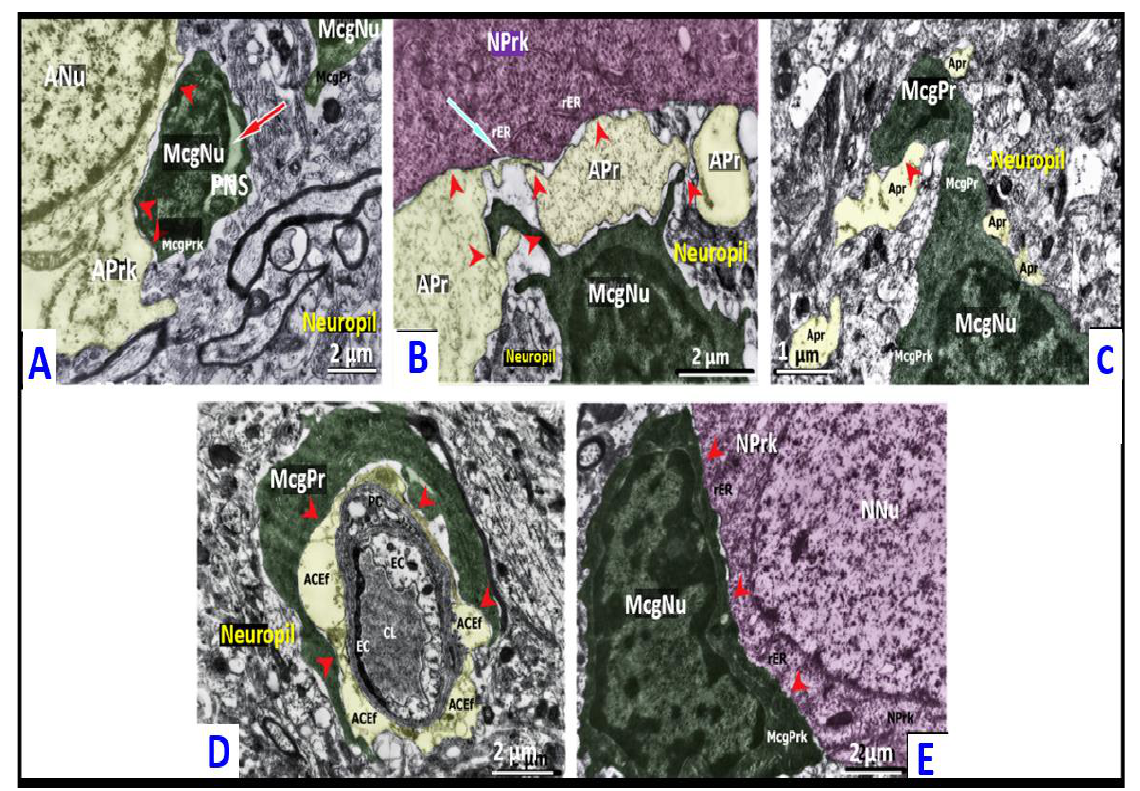
Figure 6. Microglial reactivity and interactions in acute hepatic encephalopathy. Panel ( A ) depicts an amoeboid microgliocyte (pseudo-colored green) forming direct dotted contacts (red arrowheads) with astrocyte (pseudo-colored yellow) with slight edematous changes. Note the enlarged perinuclear space of the microgliocyte (red arrow). Free extracellular space pockets surrounding microgliocyte plasma membrane. This image was taken at the border zone between the cortex and white matter of a non-survived rat (AILF-B group) 24 h after procedure. Panel ( B ) depicts an amoeboid microgliocyte (pseudo-colored green) that directly contacted the astrocytic parenchymal processes (pseudo-colored yellow) through its filopodia, which in turn formed junctions with an ischemic damaged neuron. Note the clusters of condensed mitochondria and rough ER contacting the plasma membrane close to the junction site with astroglial intermediaries that were in the neuronal perikaryon (blue arrow) and the dilated extracellular space pockets that surrounded the microglial processes. Importantly, direct contracts between cells are noted by red arrowheads. This image is from the cortex of a non-survived rat (AILF-B group) 24 h after the procedure. Panel ( C ) depicts a rod-like microgliocyte (pseudo-colored green) ’probing’ (red arrowhead) with its thick process the astrocytic parenchymal processes (yellow) in the cortex of a survived rat (AILF-A group) 24 h after the procedure. Panel ( D ) depicts the extended attachment (red arrowheads) of the process of a juxtavascular hypertrophic-like microgliocyte (pseudo-colored green) to the astroglial capillary endfeet (pseudo-colored yellow). The cortex of a survived rat (AILF-A group) 24 h after the procedure. Panel ( E ) depicts the hypertrophic-like microgliocyte (pseudo-colored green) that formed an elongated contact (red arrowheads) with the neuronal body with slightly increased electron-translucency of the nucleoplasm and condensed mitochondria. Note the translocation of the neuronal nucleus closer to the contact region; the presence of the rough endoplasmic reticulum (ER)-plasma membrane contacts. This image is from the cortex of a non-survived rat (AILF-B group) 20 h after the procedure. Note that control model cortical surveilling microgliocyte was previously described in detail and demonstrated in Figure 3A. ACEf = astroglial capillary endfeet; ANu = astrocytic nucleus; Aprk = astrocyte perikaryon; Apr = astroglial parenchymal process; CL = capillary lumen; EC = endothelial cell; McgNu = microglial nucleus; McgPrk = microglial perikaryon; McgPr = microglial process; NNu = neuronal nucleus; NPrk = neuronal perikaryon; PnS = perinuclear space; PC = pericyte; rER = rough endoplasmic reticulum.